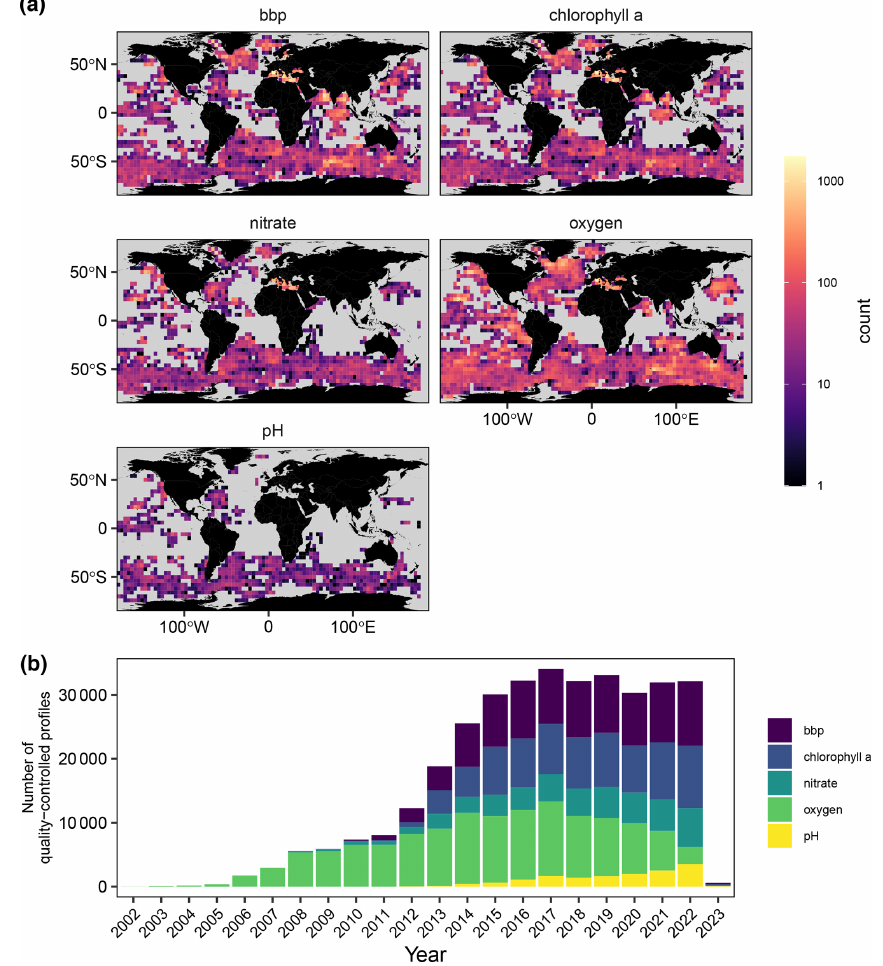
Figure 1. Spatial and temporal coverage of BGC-Argo quality-controlled pH, nitrate, chlorophyll a , oxygen, and b bp profiles: (a) the number of quality-controlled profiles for the entire period per 4 ◦ × 4 ◦ bin; (b) the number of quality-controlled profiles per year. Note that this study only uses data from 2009 to 2020 to evaluate model